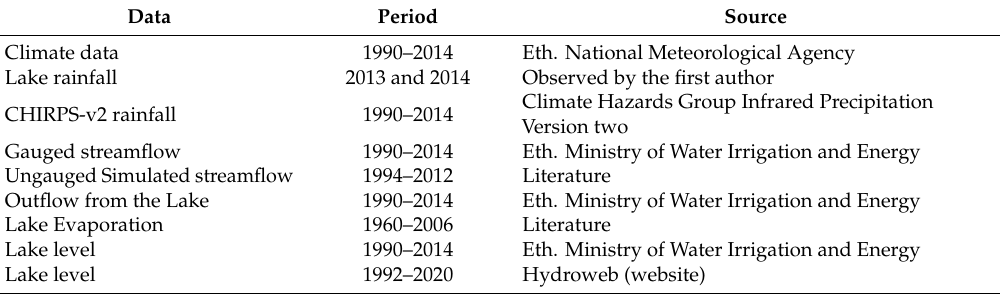
Table 3. Hydrometeorological input data, source, and time